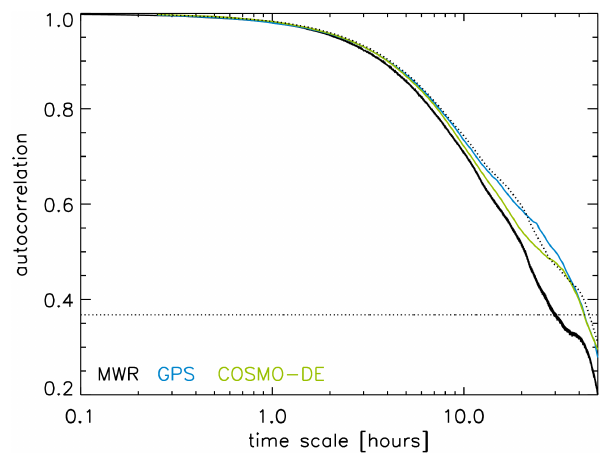
Figure 7. Autocorrelation of IWV during HOPE measured with MWR with 5s resolution (solid black), with 15min resolution (dot- ted black), with GPS (solid blue), and simulated with COSMO-DE (green). The horizontal line represents e − 1